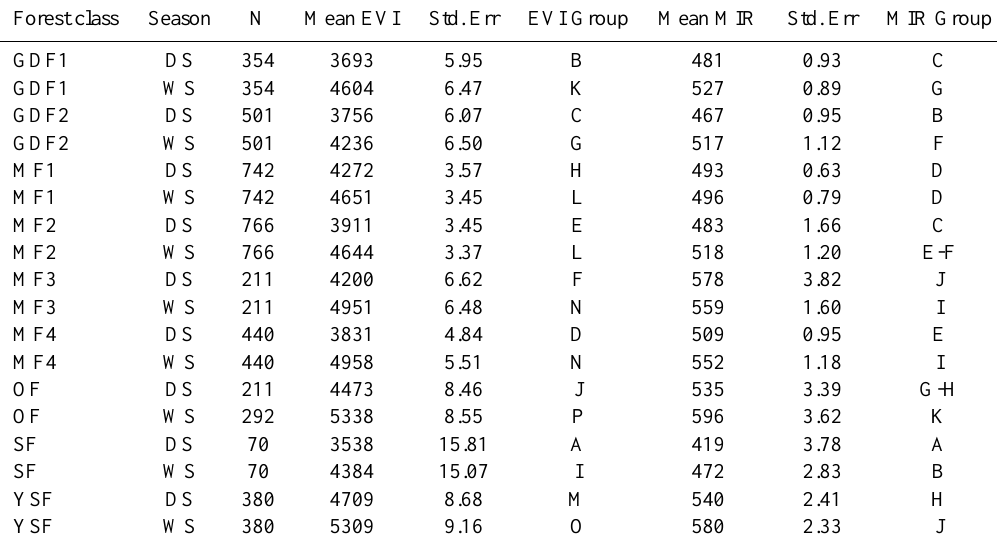
Table 1. Newman–Keuls multi-comparison test after two-factor (season + class) analysis of variance of enhanced vegetation index (EVI) and middle-infrared reflectance (MIR).